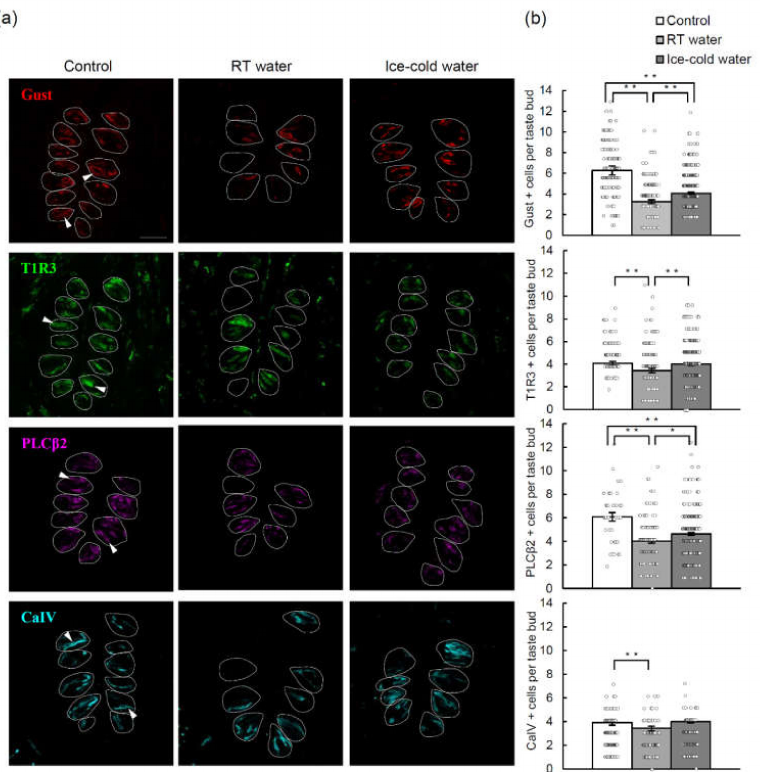
Figure 4. The number of taste bud cells expressing taste cell markers in mice that drank room temperature (RT) water or ice-cold water for 10 days following the administration of TPF (docetaxel, cisplatin and 5-fluorouracil). ( a ) Expression of gustducin (Gust, a G-protein mediating bitter and sweet taste transduction; red), taste receptor type 1 member 3 (T1R3, a sweet or umami receptor component; green), phospholipase C-beta 2 (PLC β 2, a bitter / sweet / umami transduction molecule; magenta) and carbonic anhydrase-4 (CaIV, a sour taste-sensitive cell marker; cyan) in the circumvallate papillae before (control) and 10 days after TPF administration in mice that drank RT water or ice-cold water. Arrows indicate marker-positive cells. Dotted lines outline individual taste buds. Scale bar: 50 µ m. ( b ) Quantitation of the number of immunoreactive cells per taste bud. Data are expressed as the mean ± SEM ( n = 100–286 taste buds, each). Dots indicate individual data points. * p < 0.05, ** p < 0.01 (one-way ANOVA and Tukey-Kramer post-hoc